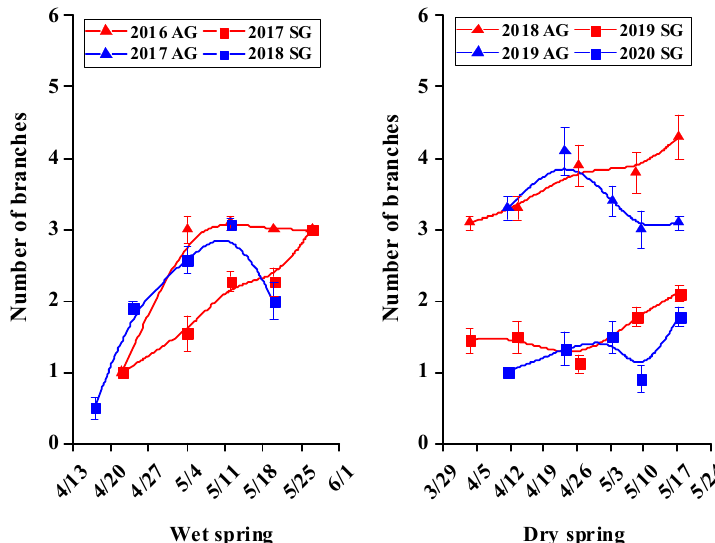
Figure 9. Increase in number of branches of spring (SG)- and autumn (AG)-germinating plants of Erodium oxyrhinchum in wet ( left ) and dry ( right ) springs. The first three periods represent the vegetative stage, and the last two periods represent the reproductive stage. Vertical bars indicate standard errors of the means (n = 8).